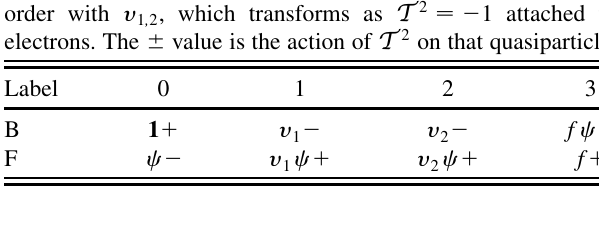
TABLE III. The beyond-group-cohomology state and the re- lated three-fermion surface topological order, attached to elec- trons. The (cid:2) value is the action of T 2 on that quasiparticle.